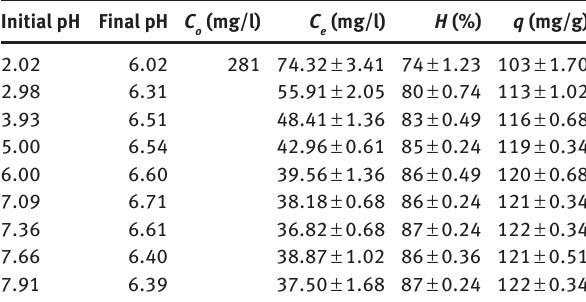
Table 4: Variation of the parameters C initial pH.